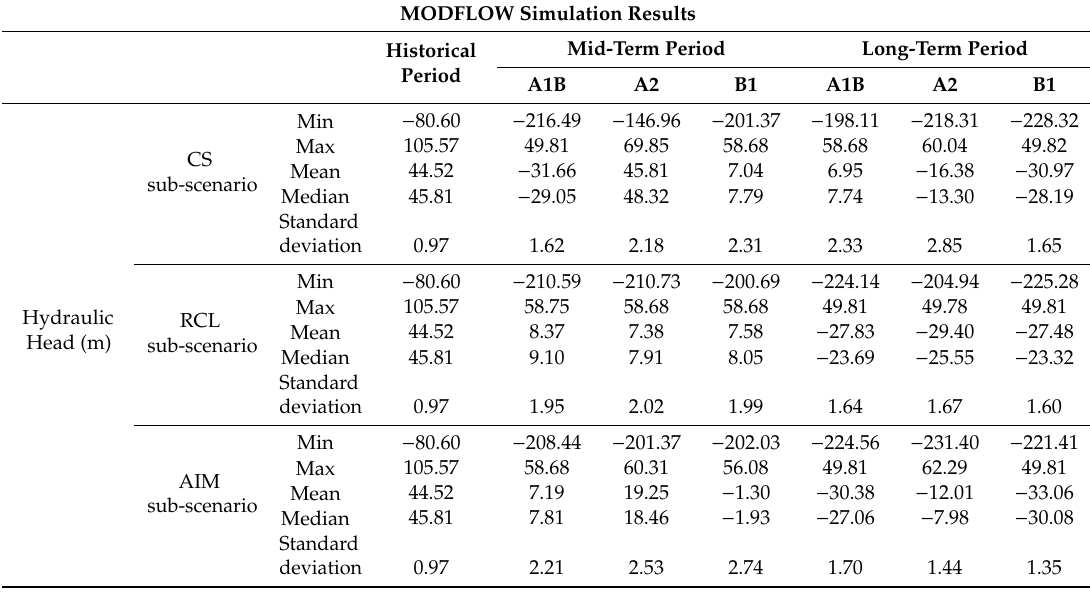
Table 3. Simulation results from MODFLOW for water demand sub-scenarios of no reservoir operation strategy.